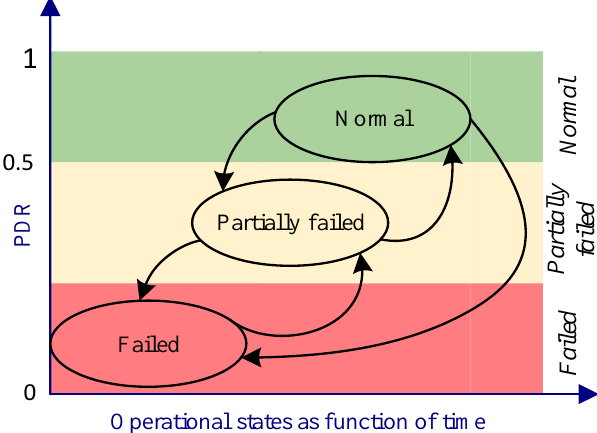
Figure 3. Morkov representation of different states of SCN operation.